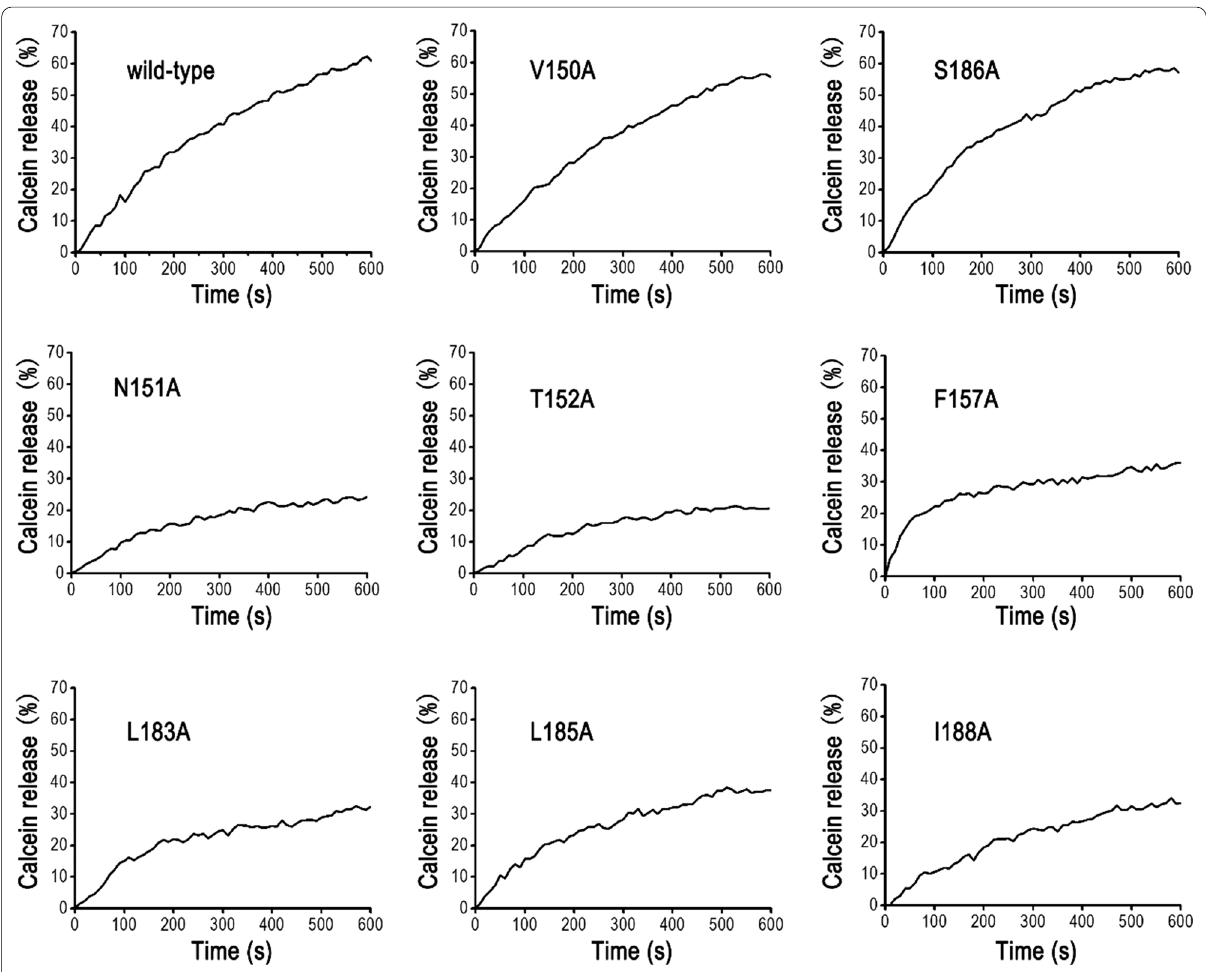
Fig. 4 Liposome leakage assay detected pore‑forming activity of Cry2Ab